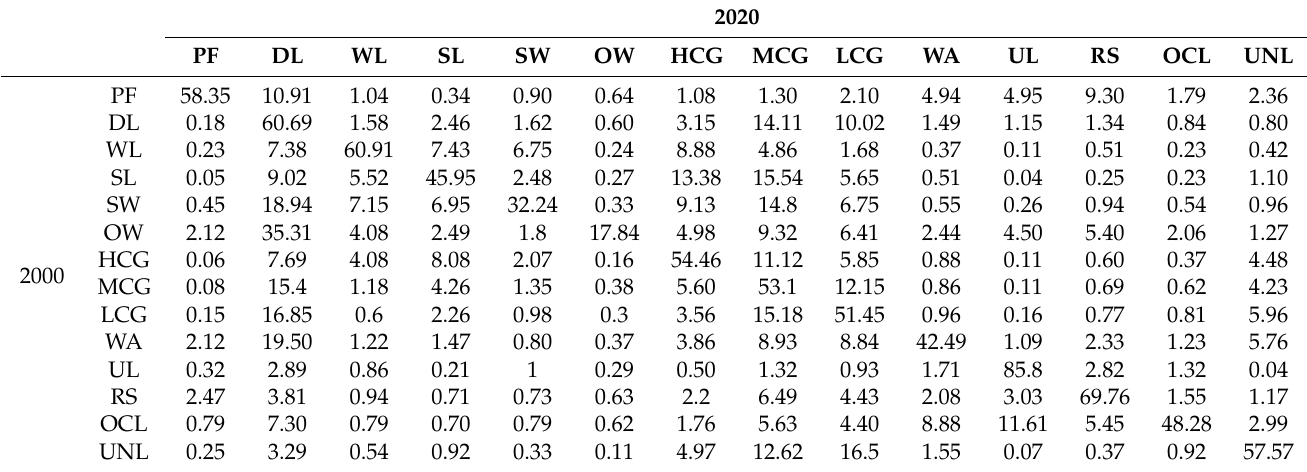
Table 7. Land use transfer matrix of the Yellow River Basin between 2000 to 2020